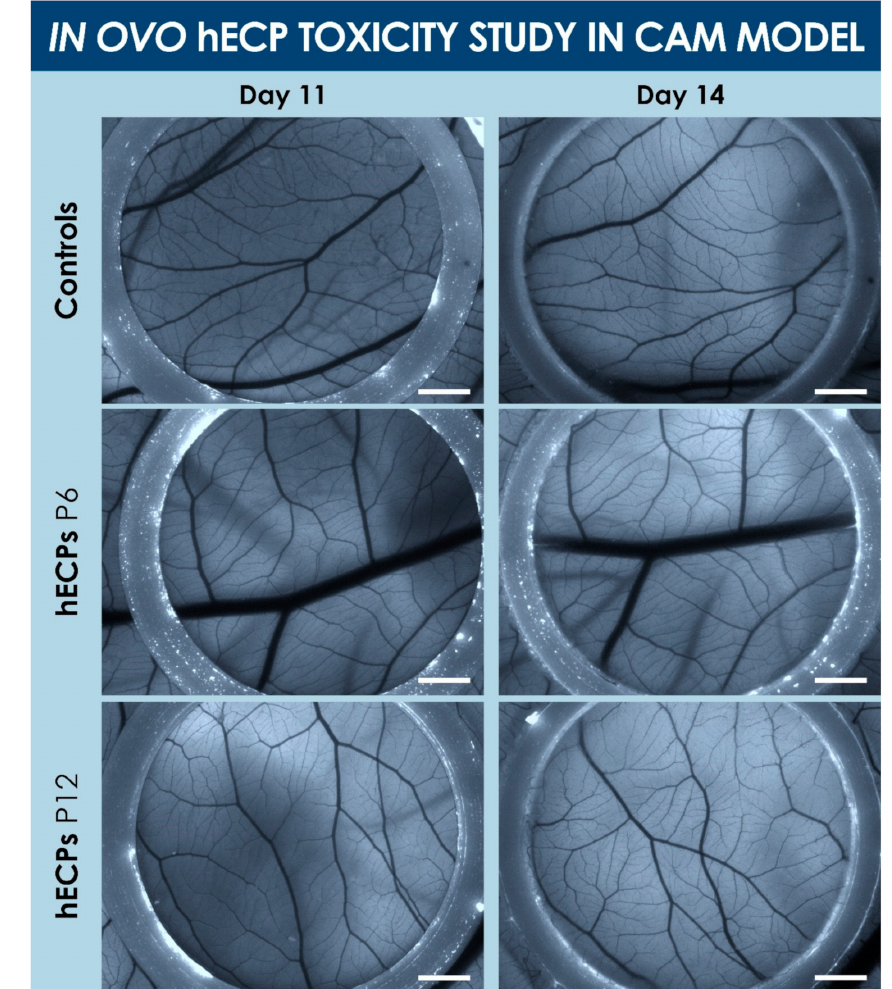
Figure 4. Representative data overview of standardized CAM experiment for evaluation of hECP embryotoxicity and angiotoxicity in ovo. Data are presented for eggs N ◦ 10, N ◦ 32, and N ◦ 12 for control, P6, and P12 groups at days 11 and 14, respectively. Scale bars = 1